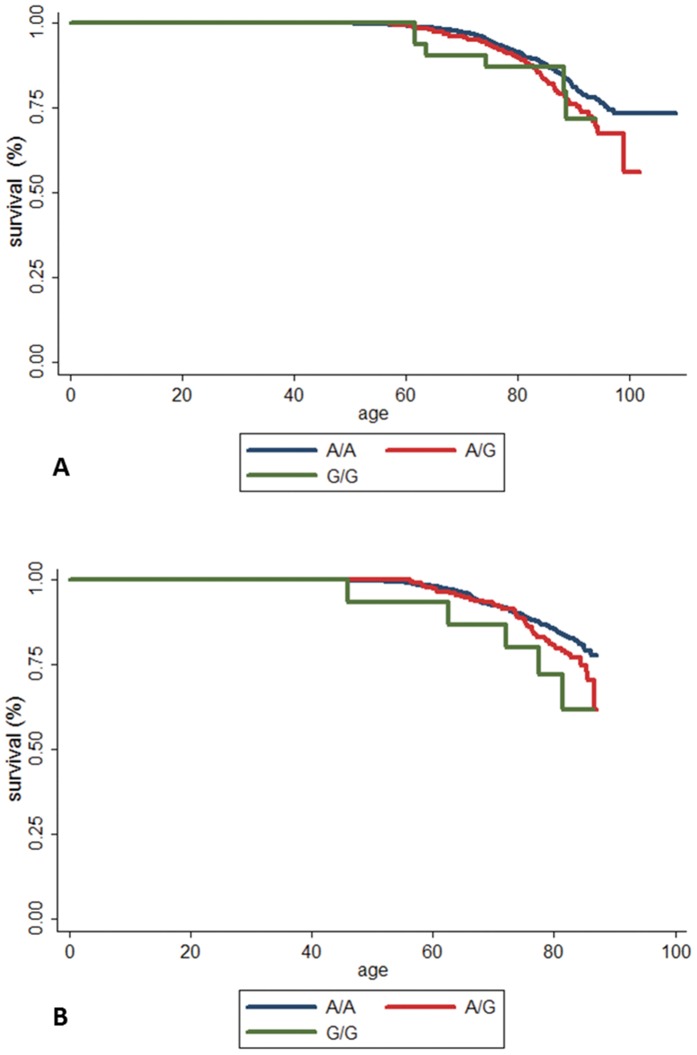
Kaplan-Meier survival function for rs4149313 and survival of MI in STR (A) and ULSAM (B).Survival function of MI for individuals having no (A/A; blue line); one (A/G; red line) or two (G/G; green line) risk alleles at ABCA1 rs4149313 locus.